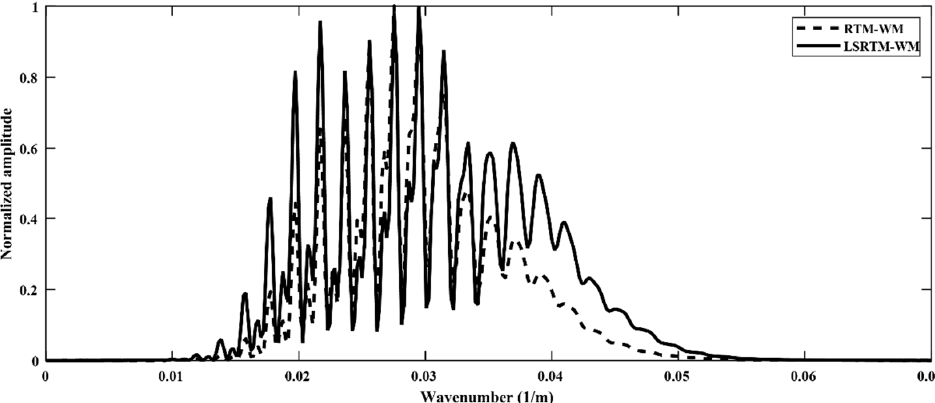
Figure 6. Wavenumber spectra comparison in the depth direction between the RTM-WM image (Figure 5a) and LSRTM-WM image (Figure 5b). The wavenumber spectrum of LSM (the solid line) was broader than that of RTM-WM (the dashed